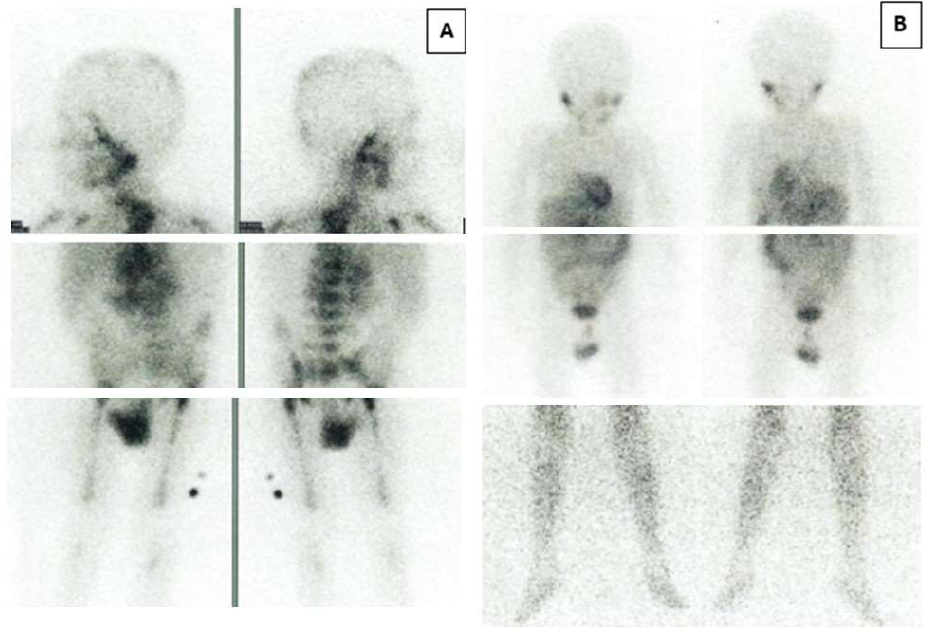
Figure 4. 123-I-MIBG skeleton images of patient number 5. Anterior ( left ) and posterior ( right ) 123-I-MIBG skeleton images before ( A ) and after ( B ) treatment.